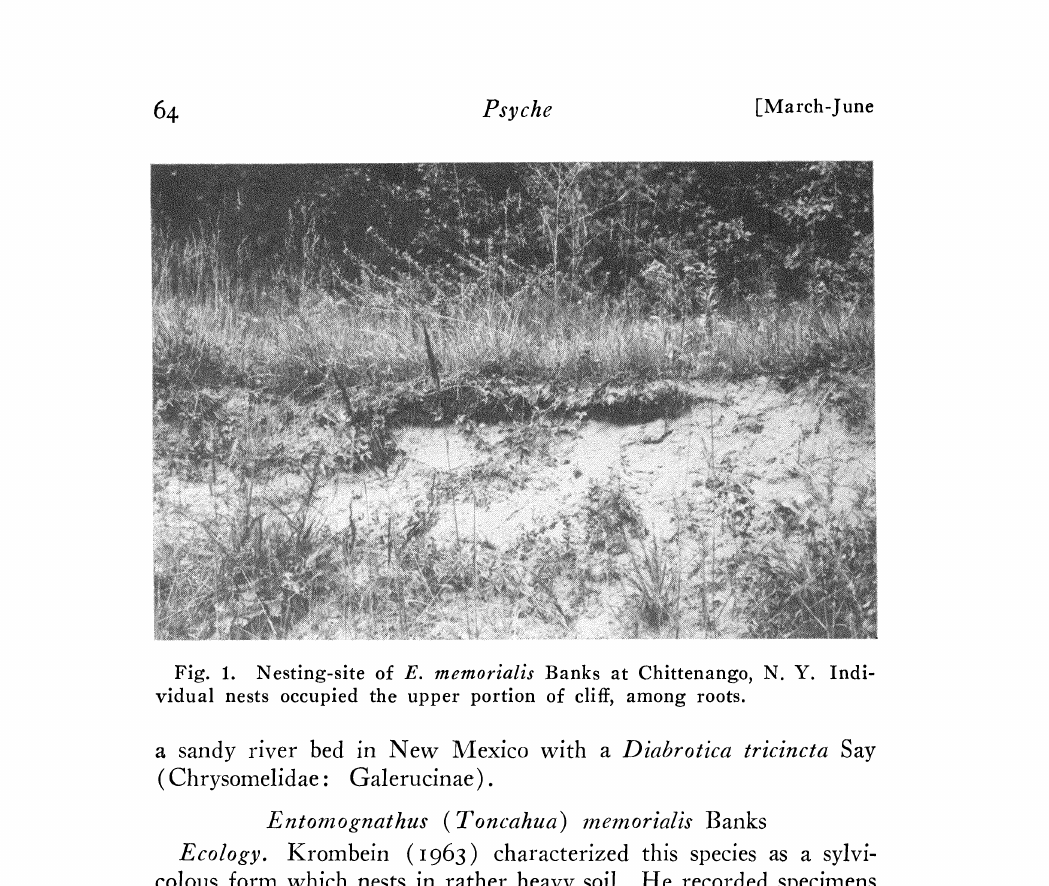
Fig. 1. Nesting-site of E. memorialis Banks at Chittenango, N. Y. Indi- vidual nests occupied the upper portion of cliff:, among roots. a sandy river bed in New Mexico with a Diabrotica tricincta Say (Chrysomelidae: